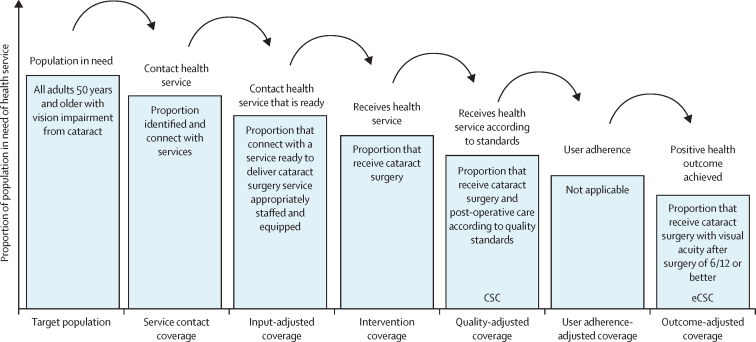
Effective coverage cascade for cataract surgical servicesCSC=cataract surgical coverage. eCSC=effective cataract surgical coverage.